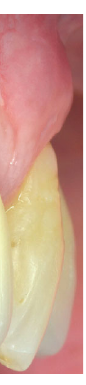
Figure 14: 3-year lateral view (note the thickness of the soft tissue corresponding to the grafted area).